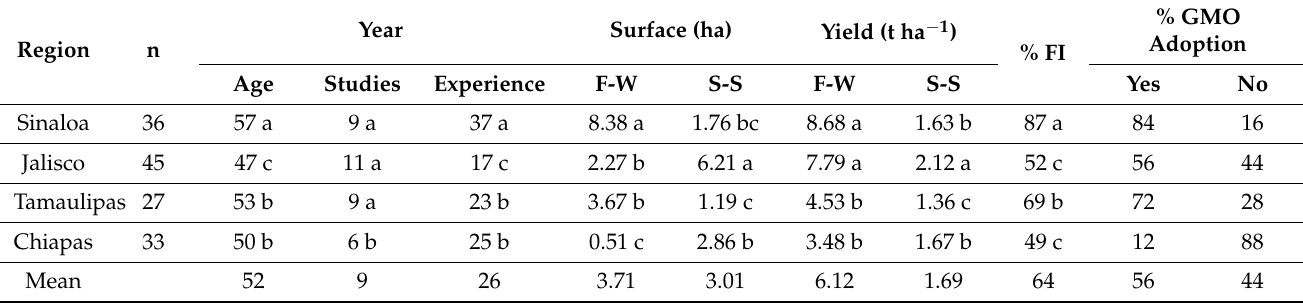
n = Number of surveys. % FI = % that the activity represents for the family income. Means with the same letter by column are not statistically different (Tukey, α =